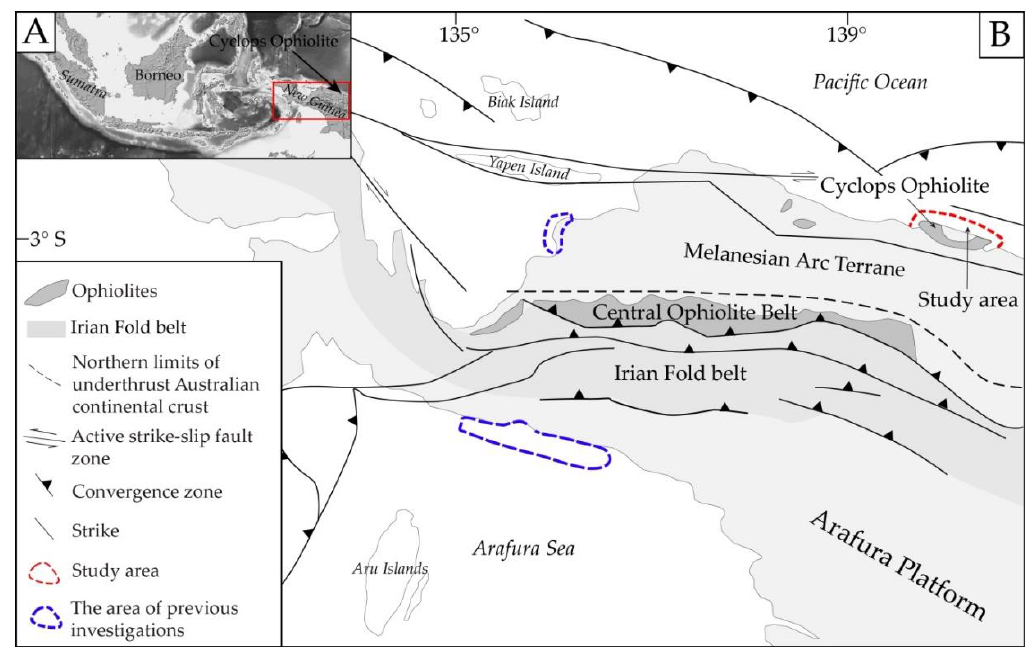
Figure 1. ( A ) Map of the Malay Archipelago; ( B ) Tectonic sketch of New Guinea Island with marked exploration area. Modified from [13,18,19,27,28].